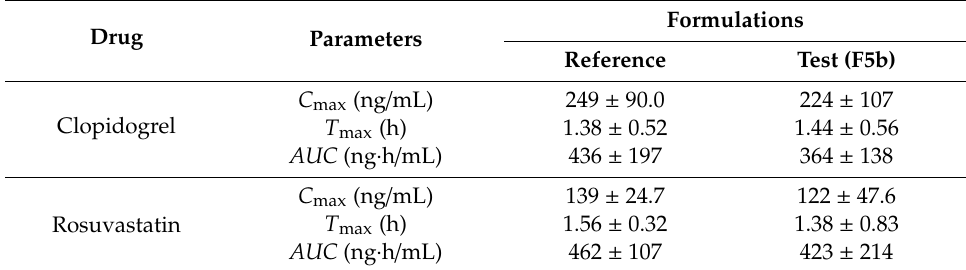
Table 5. Pharmacokinetic parameters of clopidogrel (150 mg) and rosuvastatin (20 mg) after an